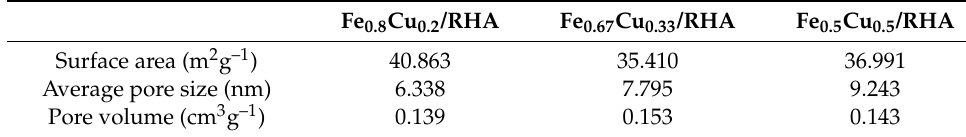
Table 1. Particulate properties of prepared